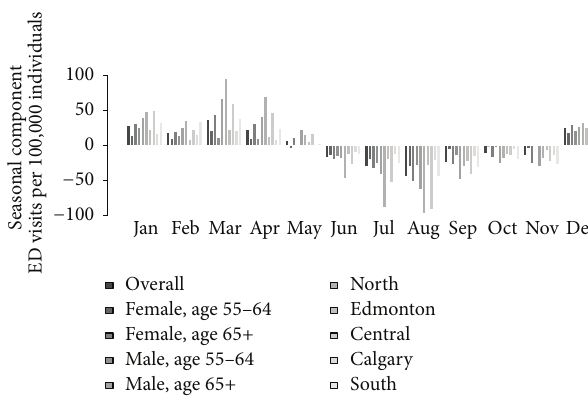
Figure 3: Comparison of seasonal components by month.